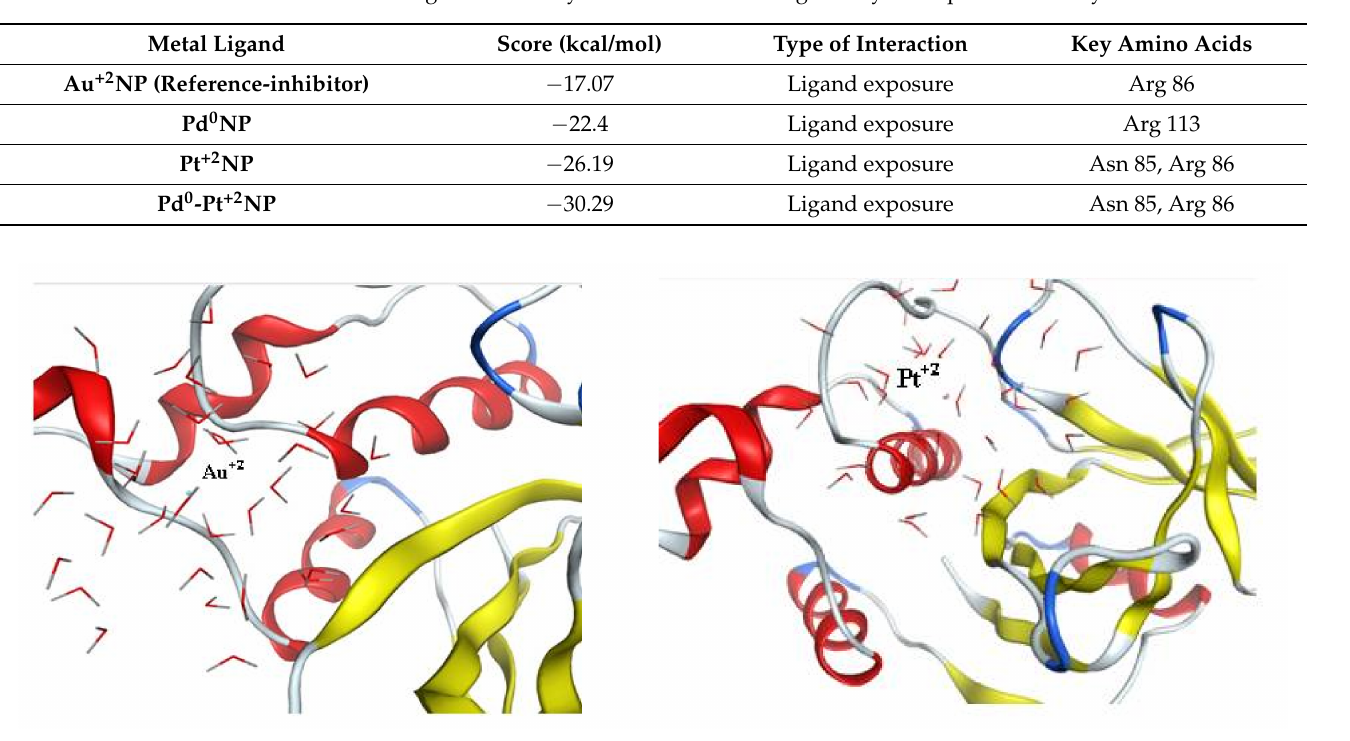
Figure 7. Left image: 3D interaction-ligand exposure between Au +2 NPand key amino acids of cysteine proteinase. Right image: 3D interaction-ligand exposure between Pt +2 NP and key amino acids of cysteine proteinase (both generated by MOEv.2010). The ribbon shape represents the receptor (cysteine proteinase), the lined molecules represents the model surface of the nanoparticles and the solid ball in the middle represents the active